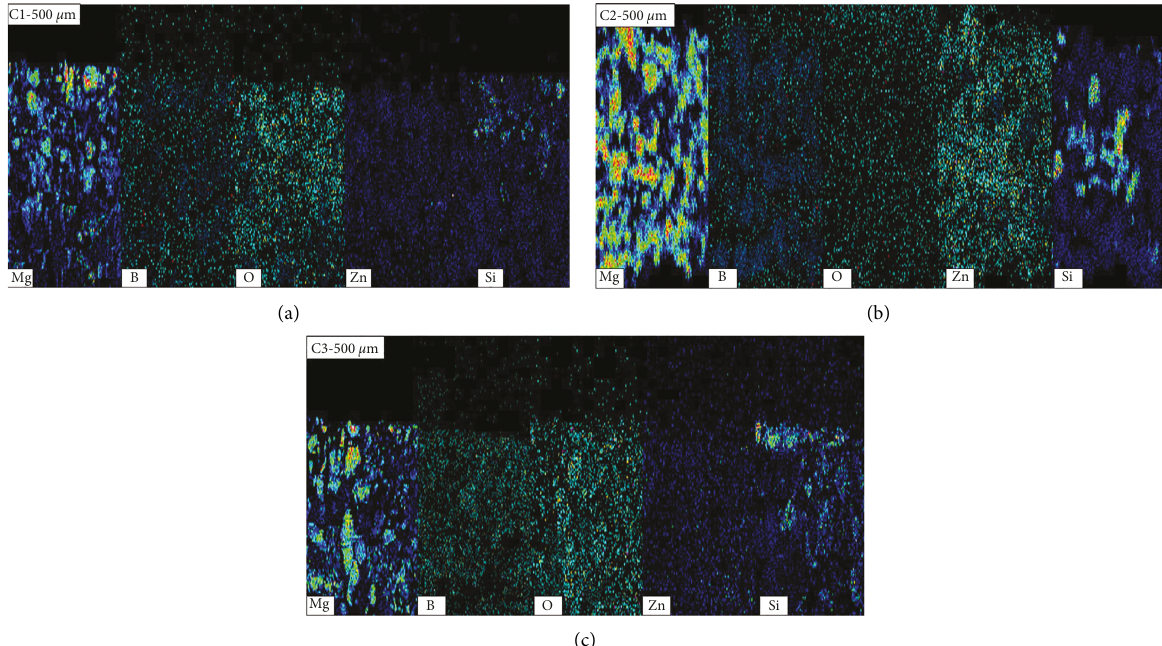
Figure 16: Microstructure analysis of coating C by EPMA (a) B1. (b) B2. (c)